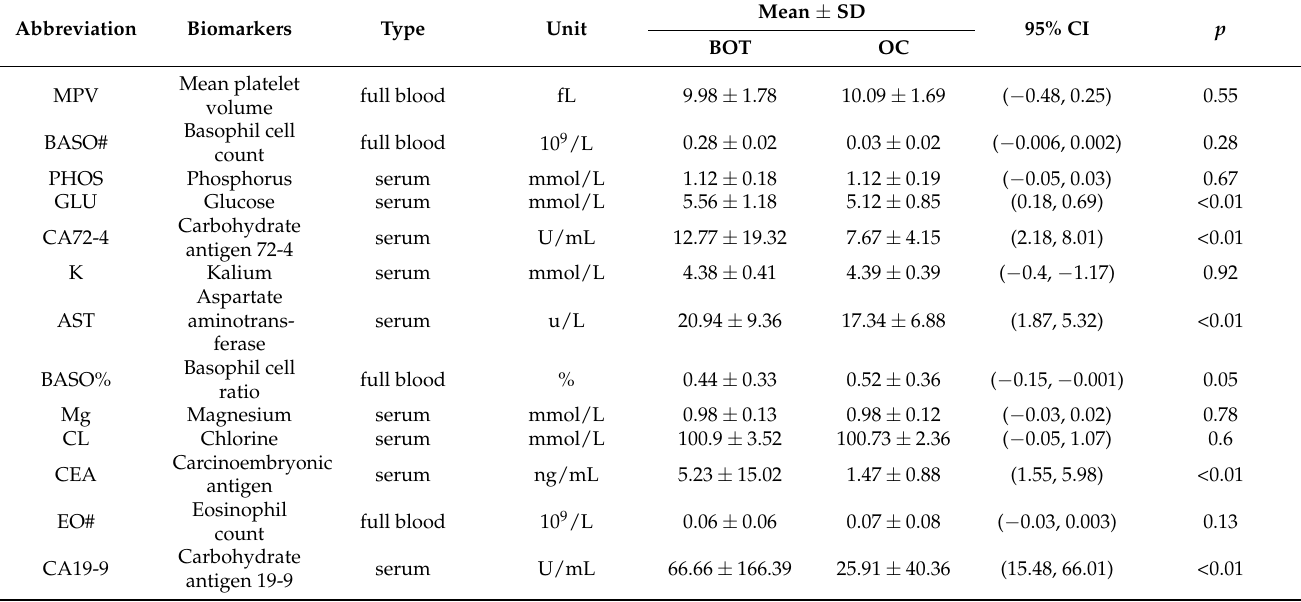
Table 2. Association between benign ovarian tumor and ovarian cancer patients. The results of independent sample t -test with blood samples, general biochemistry tests and tumor markers.